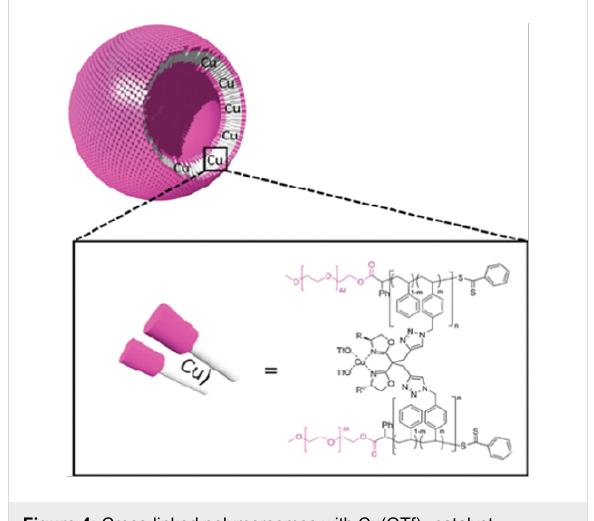
Figure 4: Cross-linked polymersomes with Cu(OTf) 2 catalyst. Reprinted with permission from [15].